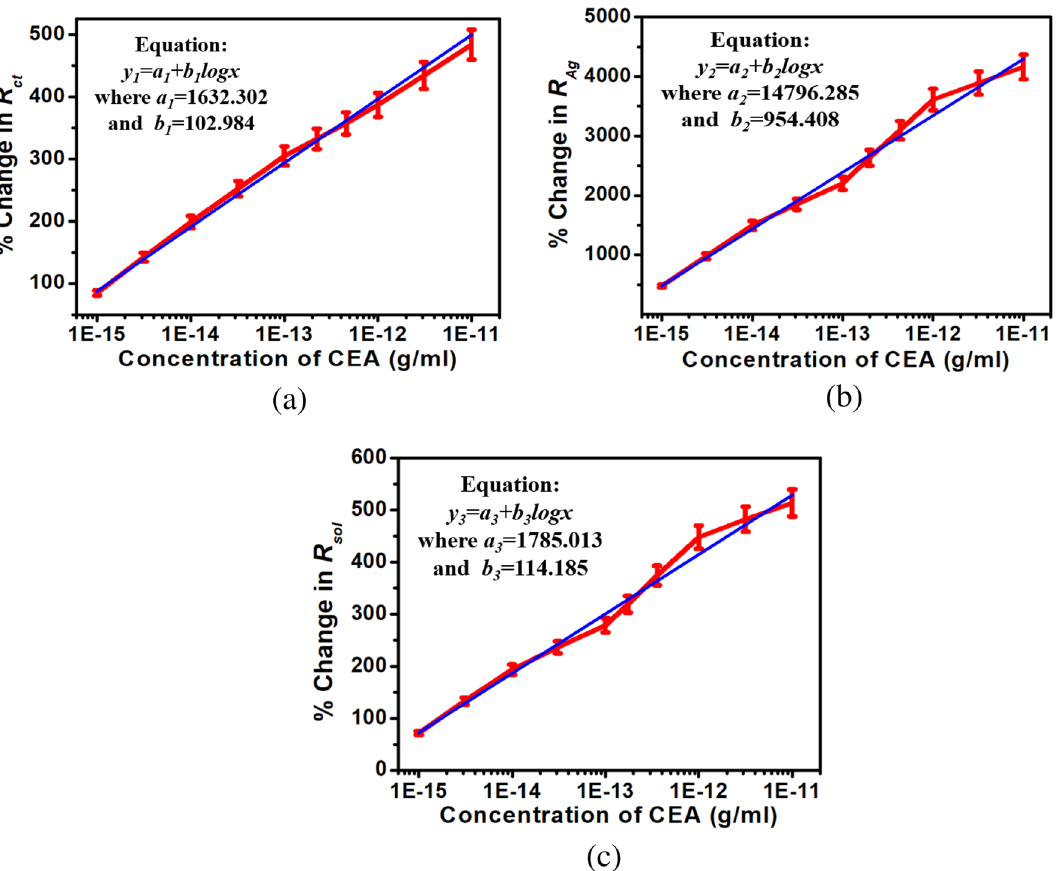
Figure 11. Calibration curves ( a ) Rct, ( b ) RAg and ( c ) Rsol with CEA